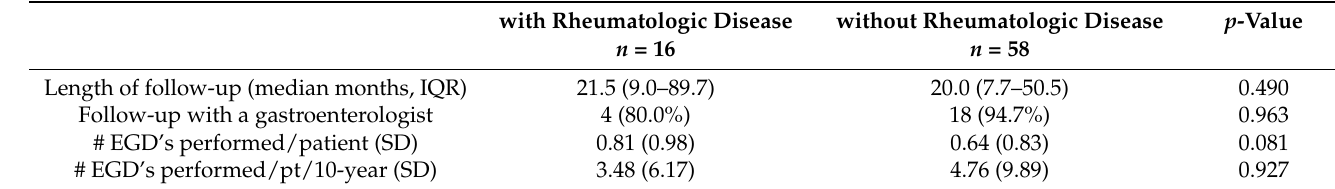
Table 4. Follow-up of absent contractility patients with rheumatologic disease versus those without. with Rheumatologic